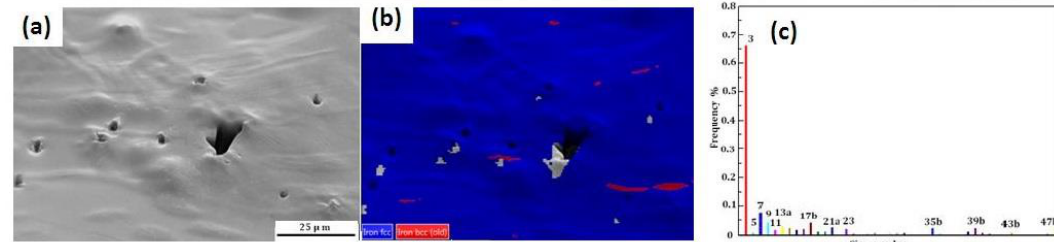
Figure 15. SEM and EBSD images of the microcrack zone produced on the interior of the samples with the strain of 0.5 at 1100 ◦ C. ( a ) electronic image; ( b ) phase distribution; ( c ) CSL distribution